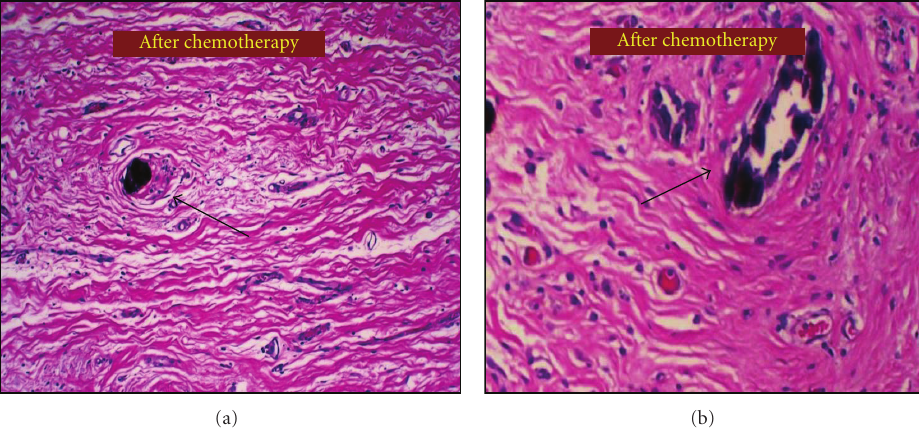
Figure 5: Pathologic findings from the surgical specimen obtained following neoadjuvant chemotherapy. Both pictures show no evidence of residual malignancy indicating a pathologic complete response. Black arrows point to benign appearing ducts with foamy macrophages, fibrous reactive tissue, and residual intraductal microcalcifications without evidence of